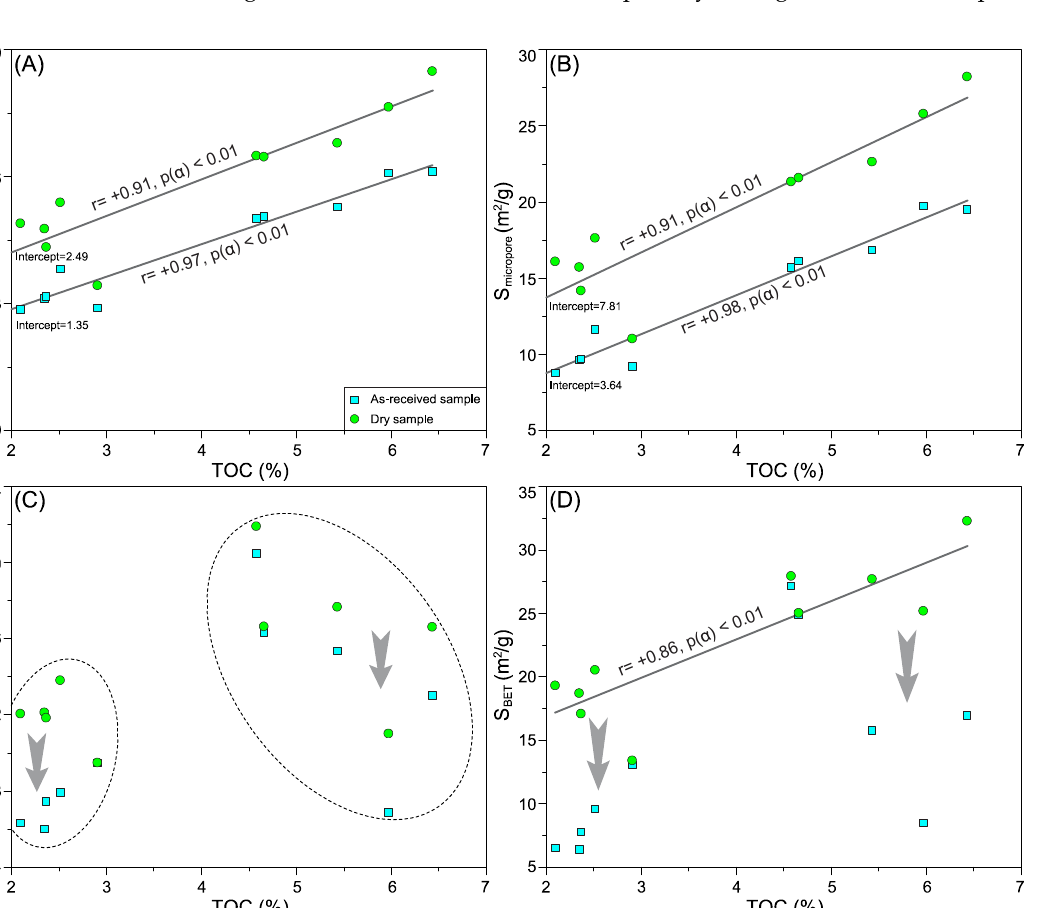
Figure 9. Cross-plots of the (V IW /V) mic or (V IW /V) n-mic ratios versus ( A ) clay content, and ( B ) TOC content of the studied WF–LMX shales from the Well PS1.